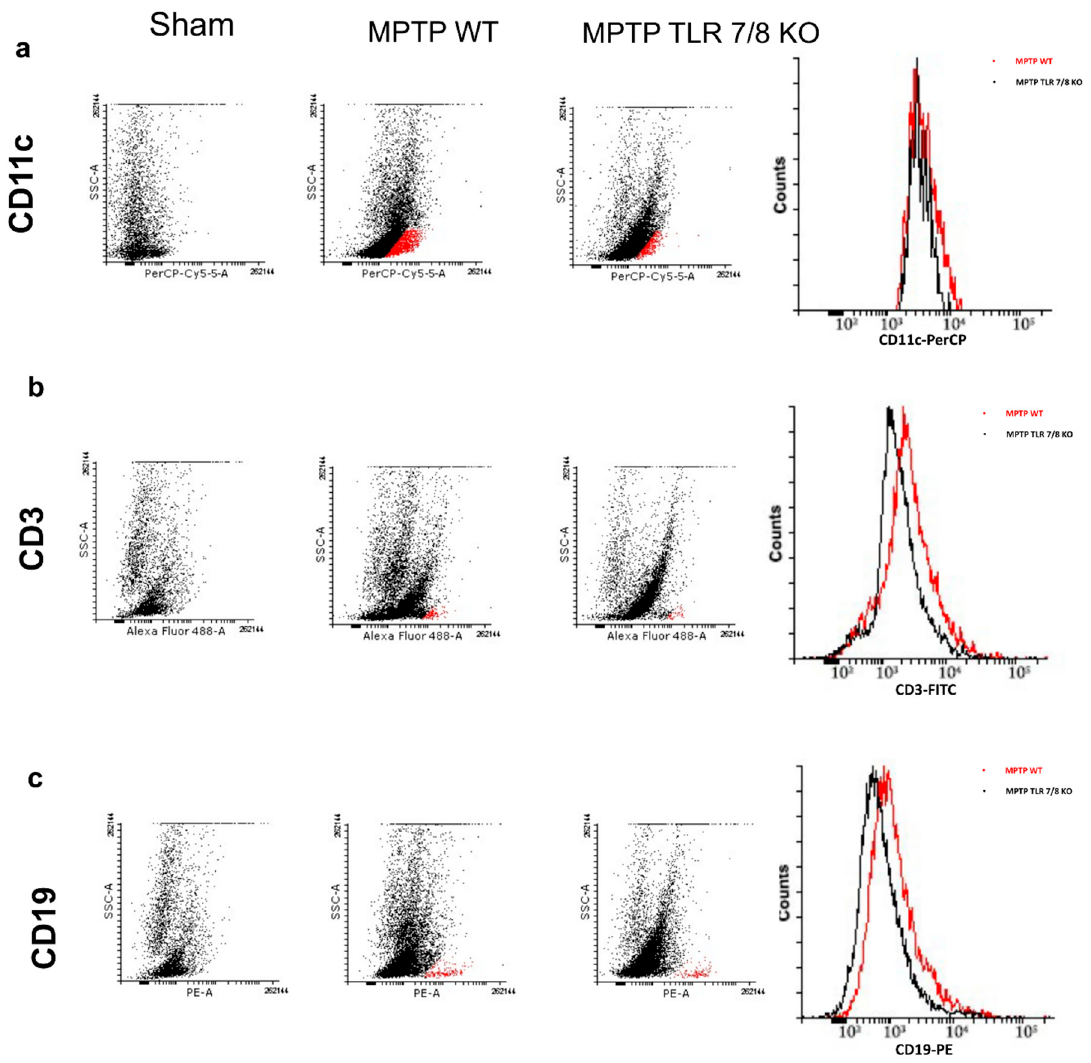
Figure 10. E ff ect of TLR7 / 8 on CD11c and CD3 expression. We analyzed CD11c + and CD3 + expression by flow cytometry. MPTP injection increase CD11c cells in the brain of WT mice compared with the SHAM group ( a ). The absence of TLR 7 / 8 showed a trend to reduce CD11c cells infiltration (Panel a ). An increase in CD3 + T cell positive numbers was observed in WT mice as compared to SHAM group ( b ), while TLR 7 / 8 KO mice showing a decreasing trend in CD3 + T cell ( b ). Moreover, CD19 B cell increased in the MPTP WT mice ( c ), while, in TLR 7 / 8 KO mice, we observed an important reduction of CD19 + B cell ( c ).